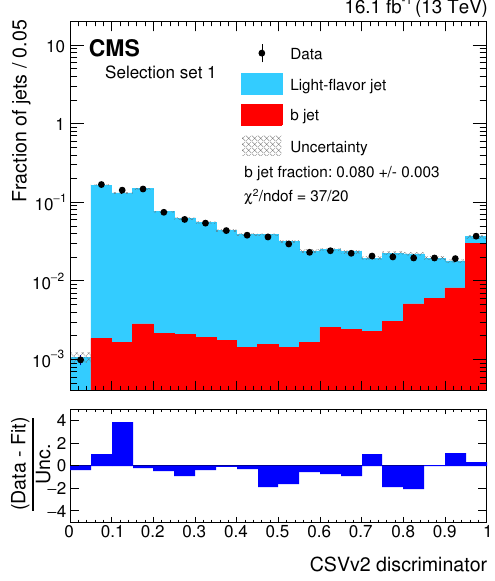
Figure 6 . Determination of the b jet fraction by (cid:12)tting the CSVv2 discriminator distribution. The red and blue distributions are the CSVv2 discriminator templates of b jets and light-(cid:13)avor jets, respectively. The black points with uncertainty bars show the data distribution. The uncertainties in the upper panel include statistical uncertainties of the b jet and light-(cid:13)avor jet templates, and the (cid:12)t uncertainties, summed in quadrature. The goodness of (cid:12)t is given by the (cid:31) 2 divided by the number of degrees of freedom (ndof). The bottom panel shows the di(cid:11)erence between data and the (cid:12)t result, divided by the combination of the statistical uncertainty of data and the uncertainty from the upper panel. The distributions are derived from kinematic samples resulting from selection set 1 in table